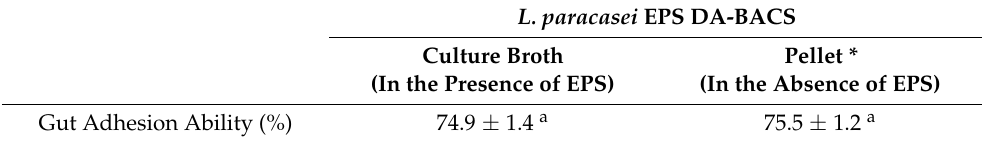
Table 2. Gut adhesion ability of L. paracasei EPS DA-BACS.